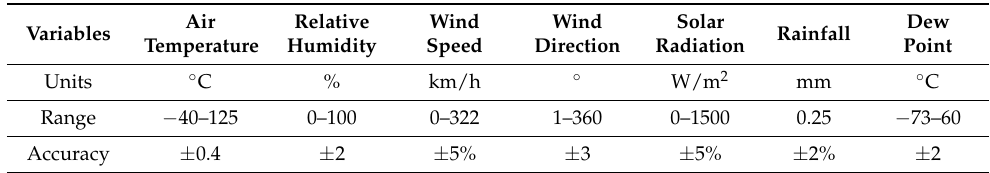
Table 1. Variables measured by the school fixed weather